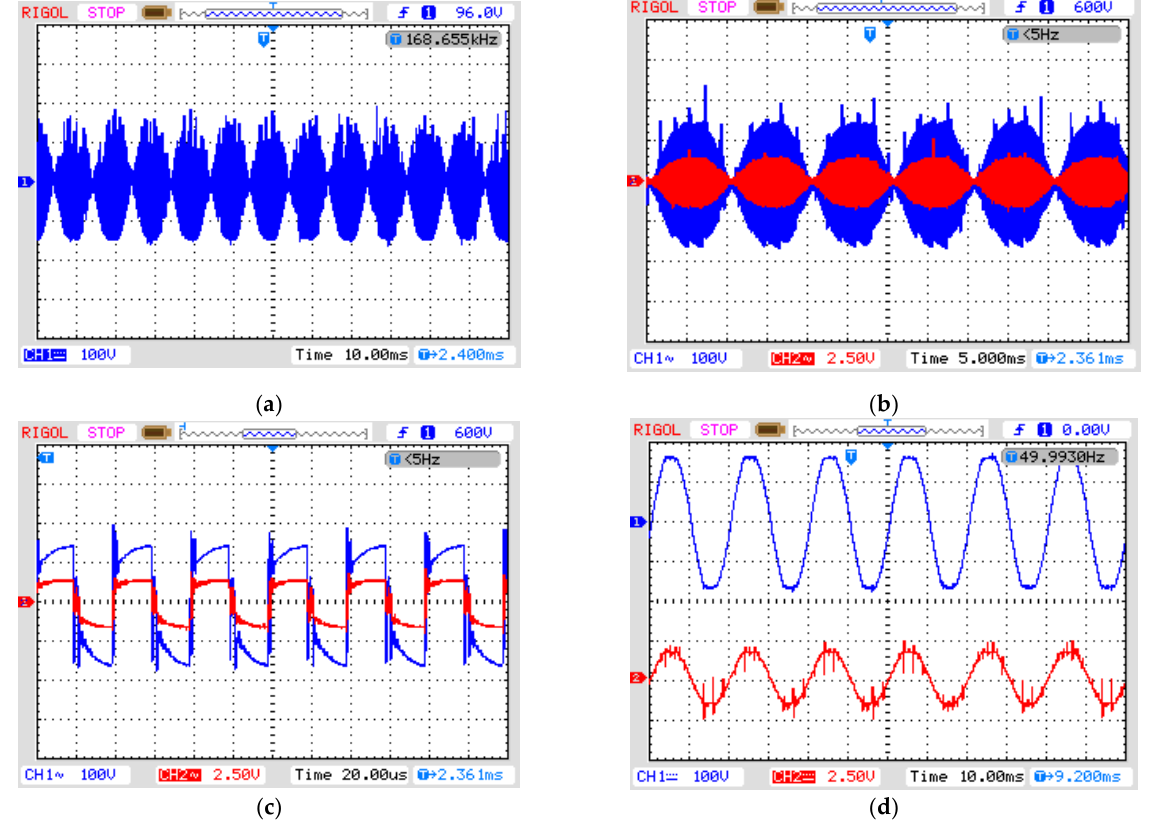
Figure 10. Practically recorded waveforms: ( a ) output voltage; ( b ) output voltage (blue) and output current (red); ( c ) output voltage (blue) and output current (red) in magnified form; ( d ) input voltage (blue) and input current (red).